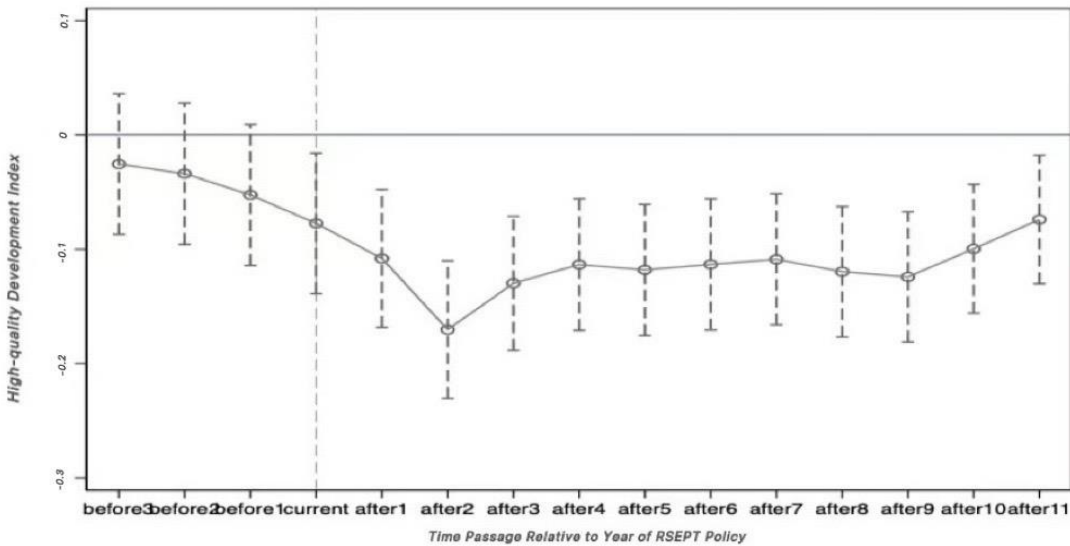
Figure 1. Parallel trend test.